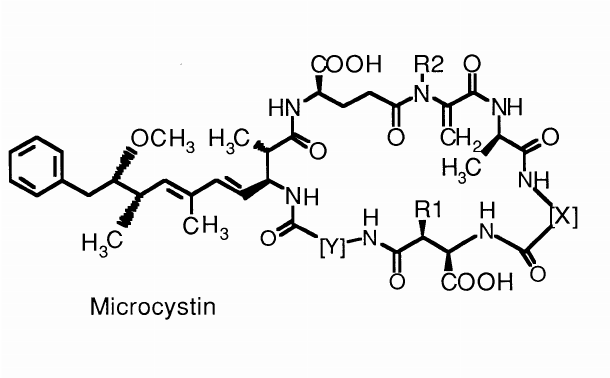
Structure of the peptide hepatotoxin microcystin, first isolated from the cyanobacterium Microcystis